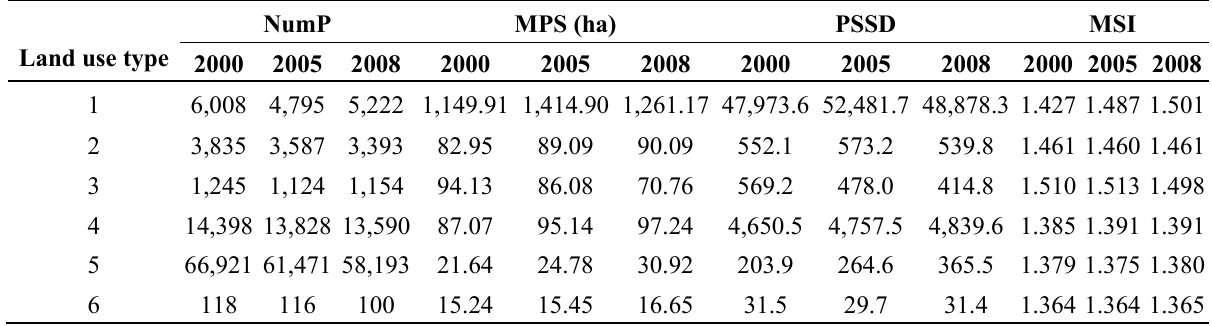
Table 4. Landscape metrics change of land use in 2000, 2005 and 2008.